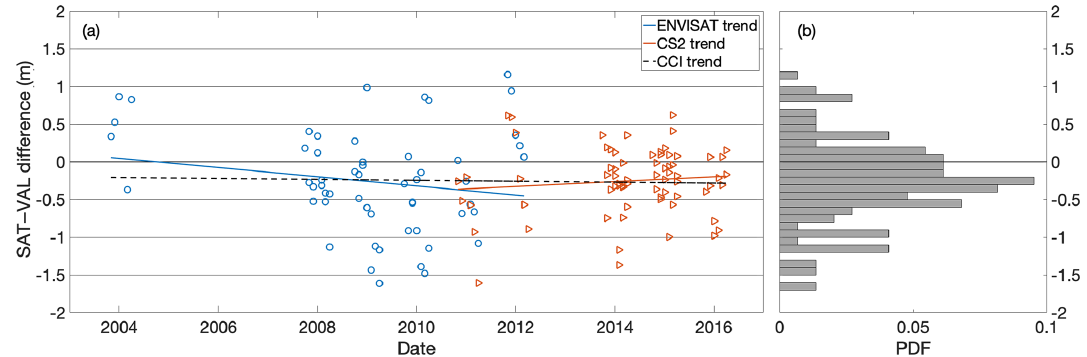
Figure 3. (a) Difference (SAT–VAL difference) between gridded monthly mean ENVISAT/CS2 and VAL ice drafts. VAL data consist of ice draft data derived from upward-looking ADCPs for the ENVISAT period (blue) and a combination of ADCP and ULS data for the CS2 period (orange). (b) Probability density function (PDF) of SAT–VAL differences over the full period from 2003 to 2016. Table 1. Statistics of the comparison of gridded monthly mean ENVISAT and ENVISATorbit draft data with VAL mean sea ice draft for the period from 2003 to 2012. RMSD and mean difference were calculated for the differences of ENVISAT minus VAL mean sea ice draft. The Pearson correlation coefficient, r , was calculated for each station. Bold correlation coefficient values indicate significant correlation at the 95% confidence level. The bottom row of values show the averages of RMSD, mean difference and correlation coefficient over all stations. ENVISAT ENVISATorbits Period Station RMSD Mean difference r RMSD Mean difference